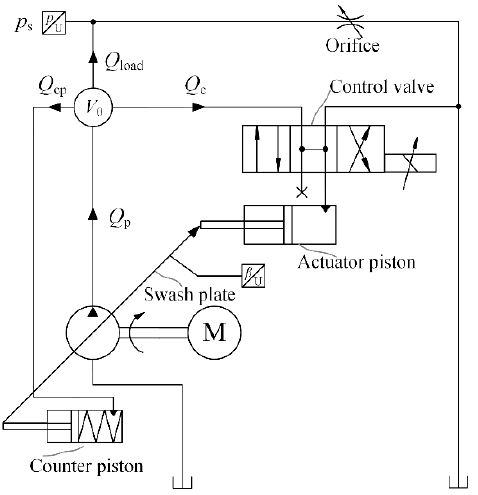
Figure 2. The control circuit of the self-supplied variable displacement pump.